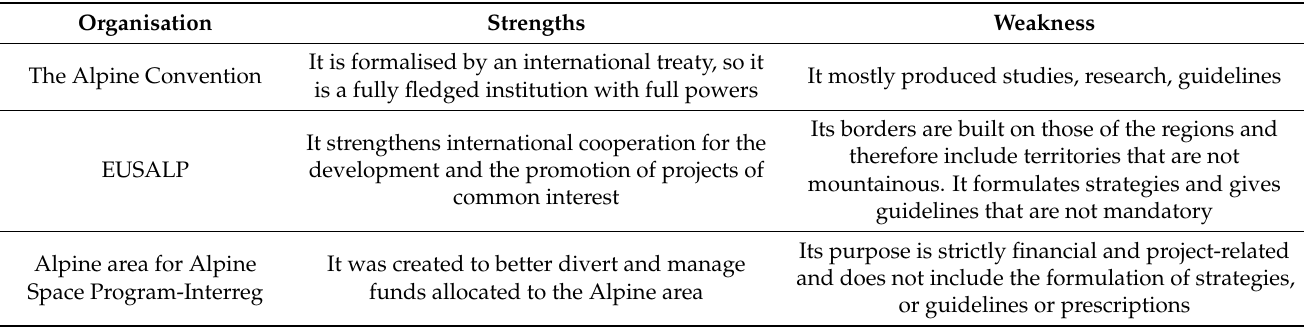
Table 3. The list of the strengths and weaknesses of each